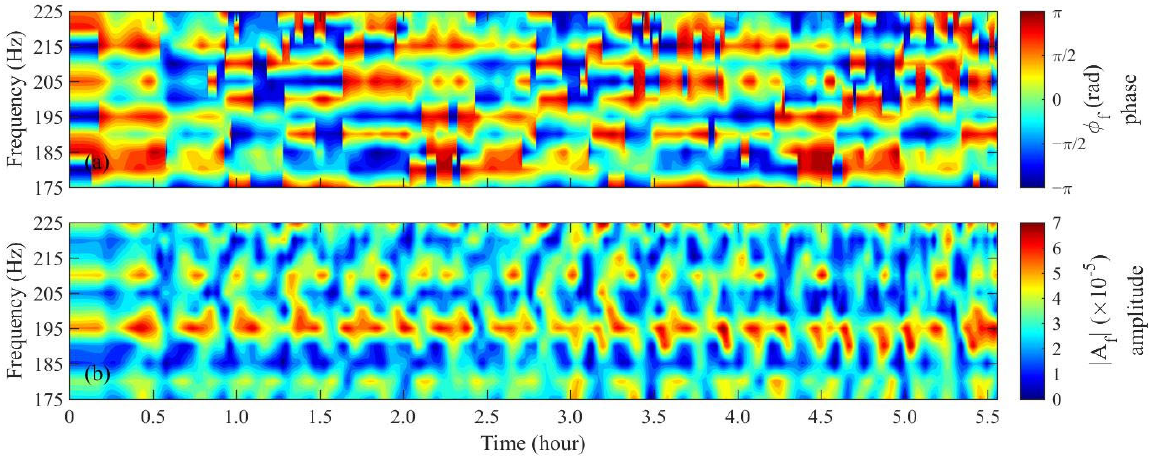
Figure 13. Contour plots of the simulated sound pressure phase and amplitude versus frequency and time. ( a ) the phase ∅ f ( t ) and ( b ) the amplitude A f ( t ) . To show the temporal fluctuations of the sound field more clearly, the spectra were calculated. First, the temporal correlation coefficient C ( t , t + τ ) in Equation (9) was replaced with the complex sound pressure p f ( t ) , amplitude A f ( t ) , and phase ∅ f ( t ) to obtain the spectra Q f , p , Q f , A , and Q f , ∅ , respectively. Then, the frequency-averaged spectra Q p , Q A , and Q ∅ were obtained by averaging over the frequency band. Finally, the depth- averaged spectra Q p , Q A , and Q ∅ are calculated using the frequency-averaged spectra. The normalized frequency ‐ averaged spectra and depth ‐ averaged spectra are presented in Figure 14.